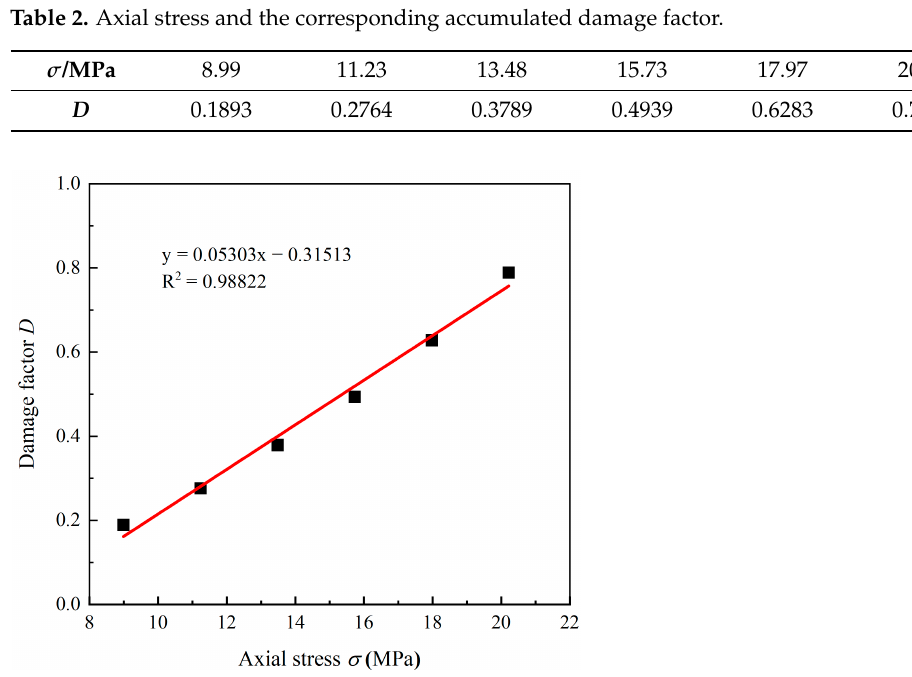
Figure 11. Relationship between the accumulated damage factor and axial